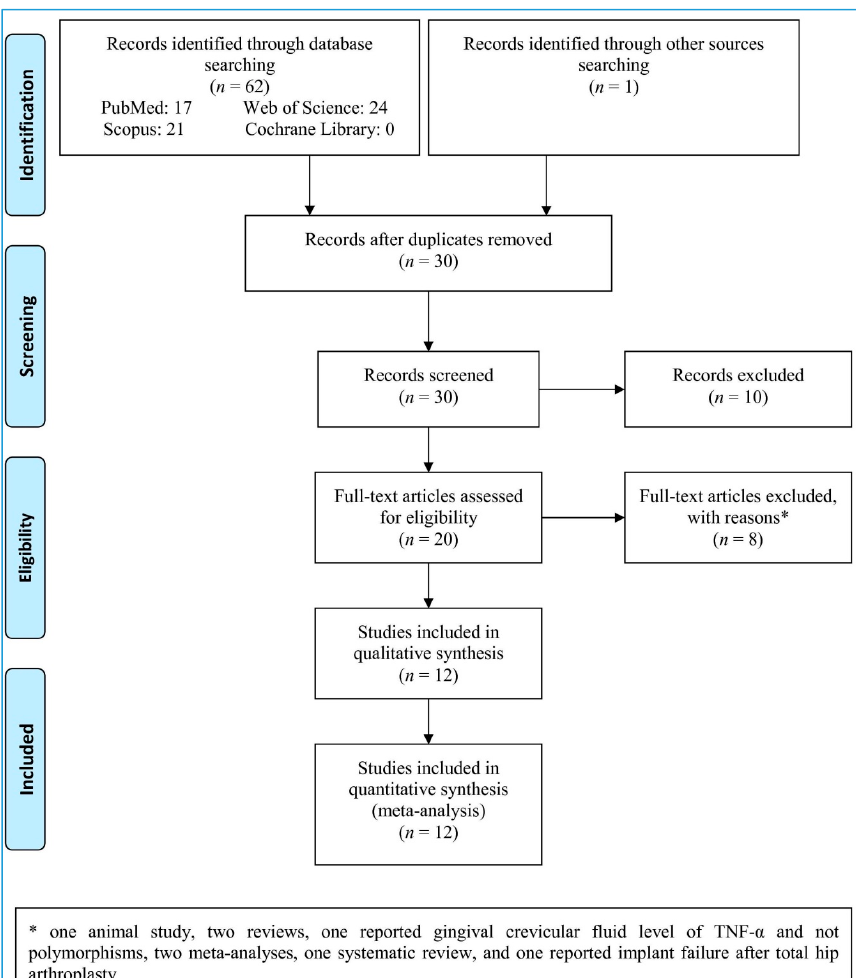
Figure 1. Flow chart of the study selection.